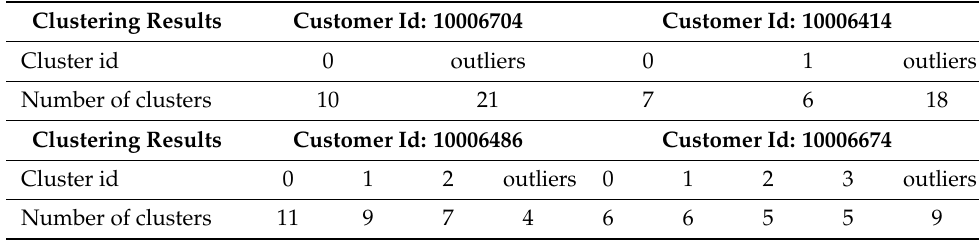
Figure 8. Clustering results of daily load curves of selected residents ( a ) Customer id:10006704; ( b ) Customer id: 10006414; ( c ) Customer id: 10006486; ( d ) Customer id: 10006674. Table 4. Clustering results of some selected households shown in Figure